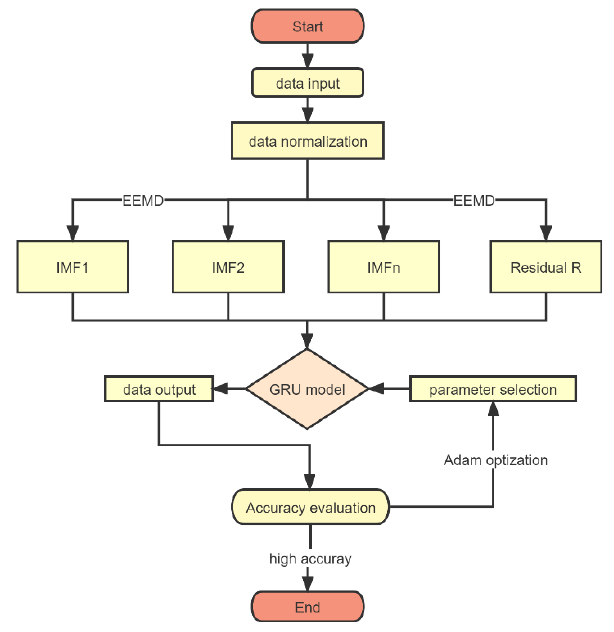
Figure 3. EEMD-ADAM-GRU construction flow